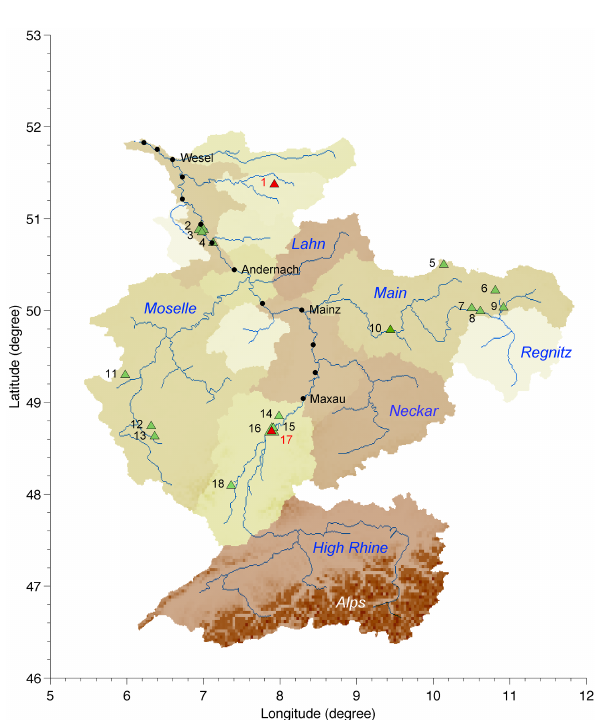
Figure 1. River gauge (circle) and well (triangle) locations over the Rhine River basin used in this paper. Red triangles indicate Sun- dern (1) and A319C locations (17). Names of all well locations are given in Table